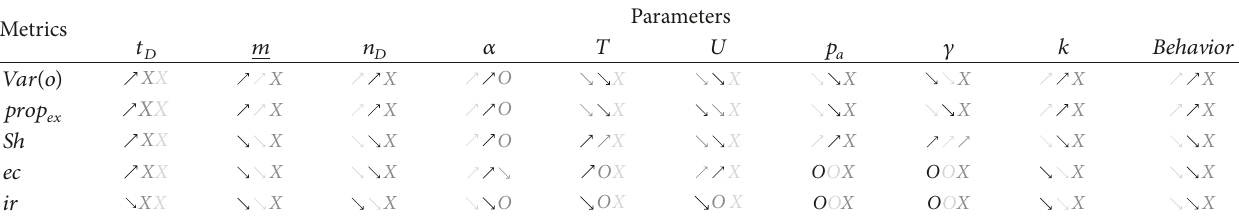
Nota: gray symbols correspond to dyadic dynamics, light gray to deliberative dynamics, and bold black to mixed dynamics. Given a scenario, the symbol 𝑋 stands for constant parameter and 𝑂 for insignificant marginal effect, and as parameters grow: for positive (negative) marginal effect for the parameter. From left to right at the parameter level, the leftmost arrow corresponds to the scenario with the strongest (in absolute value) marginal effect of the parameter (with respect to to its factors). Example: Let 𝑝 be a parameter, and 𝑂 stands for “ 𝑝 has a significant positive effect in dyadic discussion scenario, negative in the deliberative one, and insignificant in mixed discussion. The positive effect in dyadic discussion is greater than the absolute value of the negative one in the purely deliberative